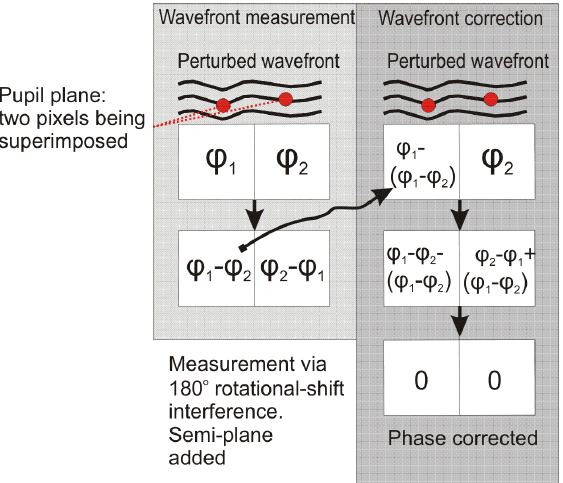
Figure 4. Illustration (in left column) for the measurement of wavefront by 180 ◦ interfero-coronagraph and (in right column) for the correction of wavefront by an AO LC SLM placed before the 180 ◦ interfero-coronagraph. (Note that here the corrected “left” side of SLM is shown. The same result could be achieved with “right” side just by altering the sign before ϕ 1 − ϕ 2